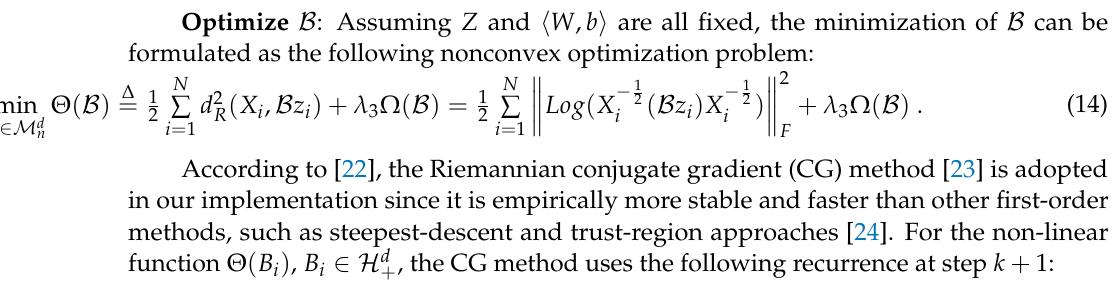
Figure 2. Experiment on simulated PolSAR data. ( a ) Eigenvalue while optimizing sparse coding z . ( b ) Eigenvalue while optimizing dictionary B